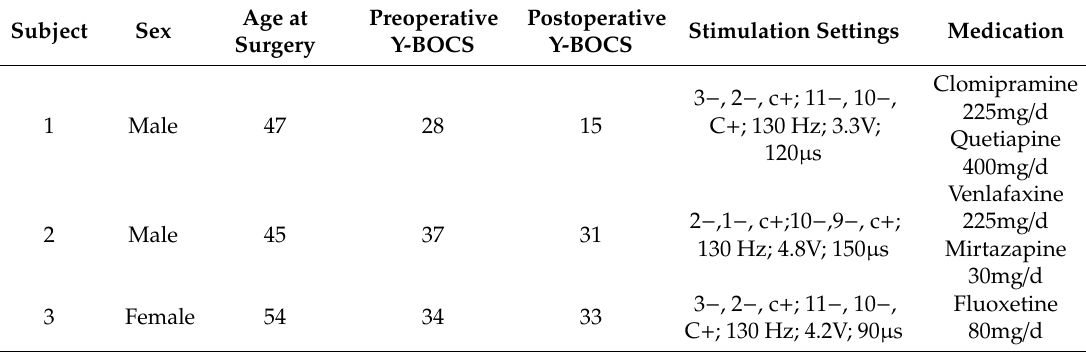
Table 1. Demographic data and stimulation settings and current psychotropic